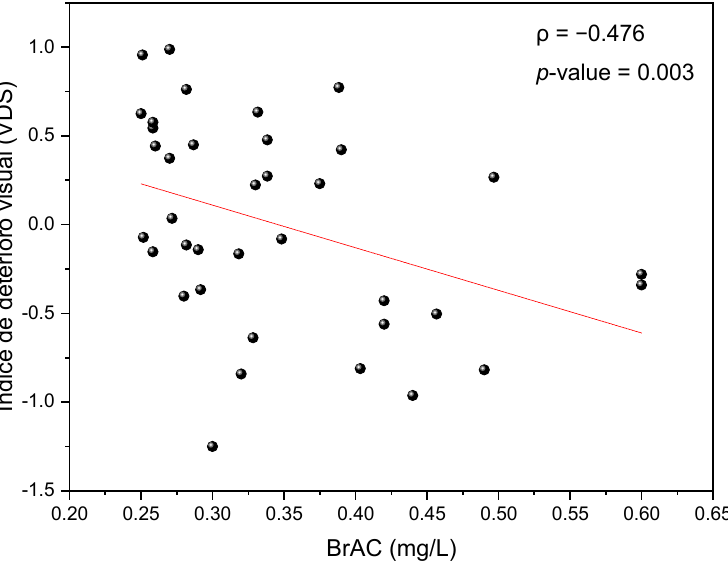
Figure 3. Visual Deterioration Score (VDS) as a function of the breath alcohol content (BrAC, in mg/L) reached for each participant.